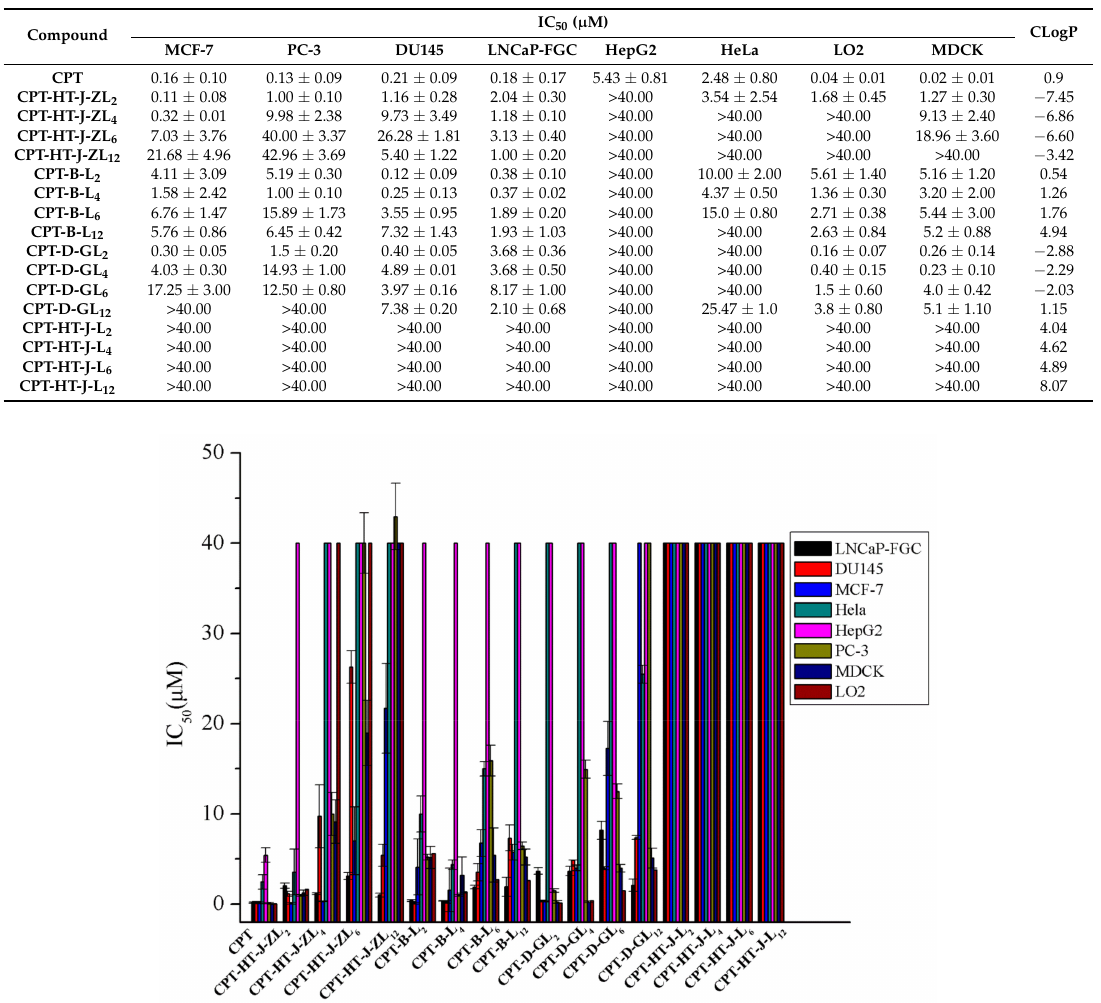
Figure 1. The cytotoxicities of the CPT-HT-J-ZLn and the PSMA hydrolysate CPT-D-GLn to different tumor and normal